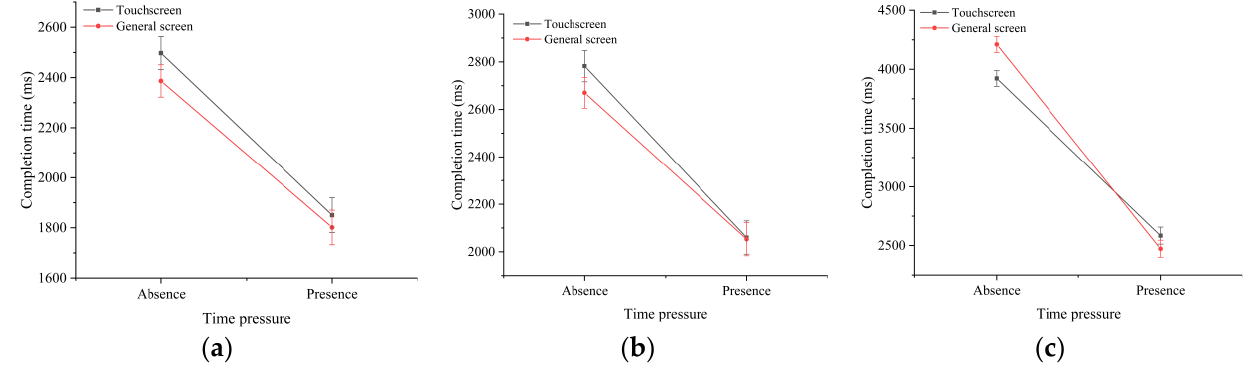
Figure 5. Interaction effects of the screen type and time pressure on the completion time of tasks with different difficulties: ( a ) low difficulty; ( b ) medium difficulty; and ( c ) high difficulty. Table 1. Completion time (milliseconds (ms)) statistics under different time pressures and task dif- ficulties.